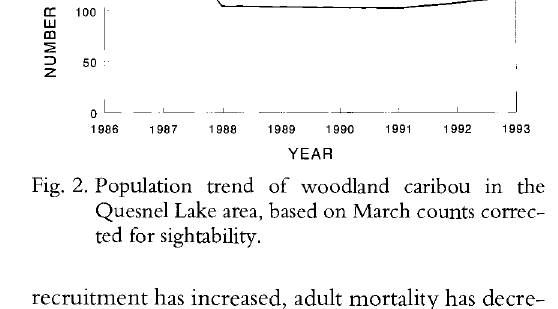
Fig. 2. Population trend of woodland caribou in the Quesnel Lake area, based on March counts correc ted for